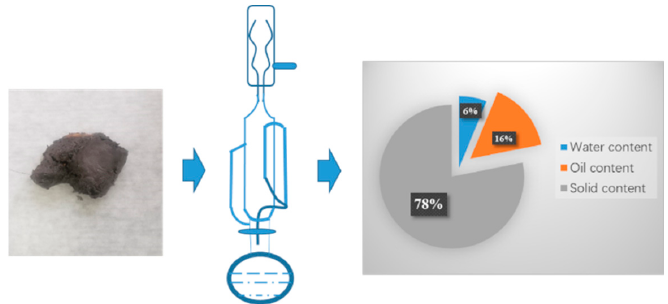
Figure 1. Soxhlet extraction method to measure oil and water content.